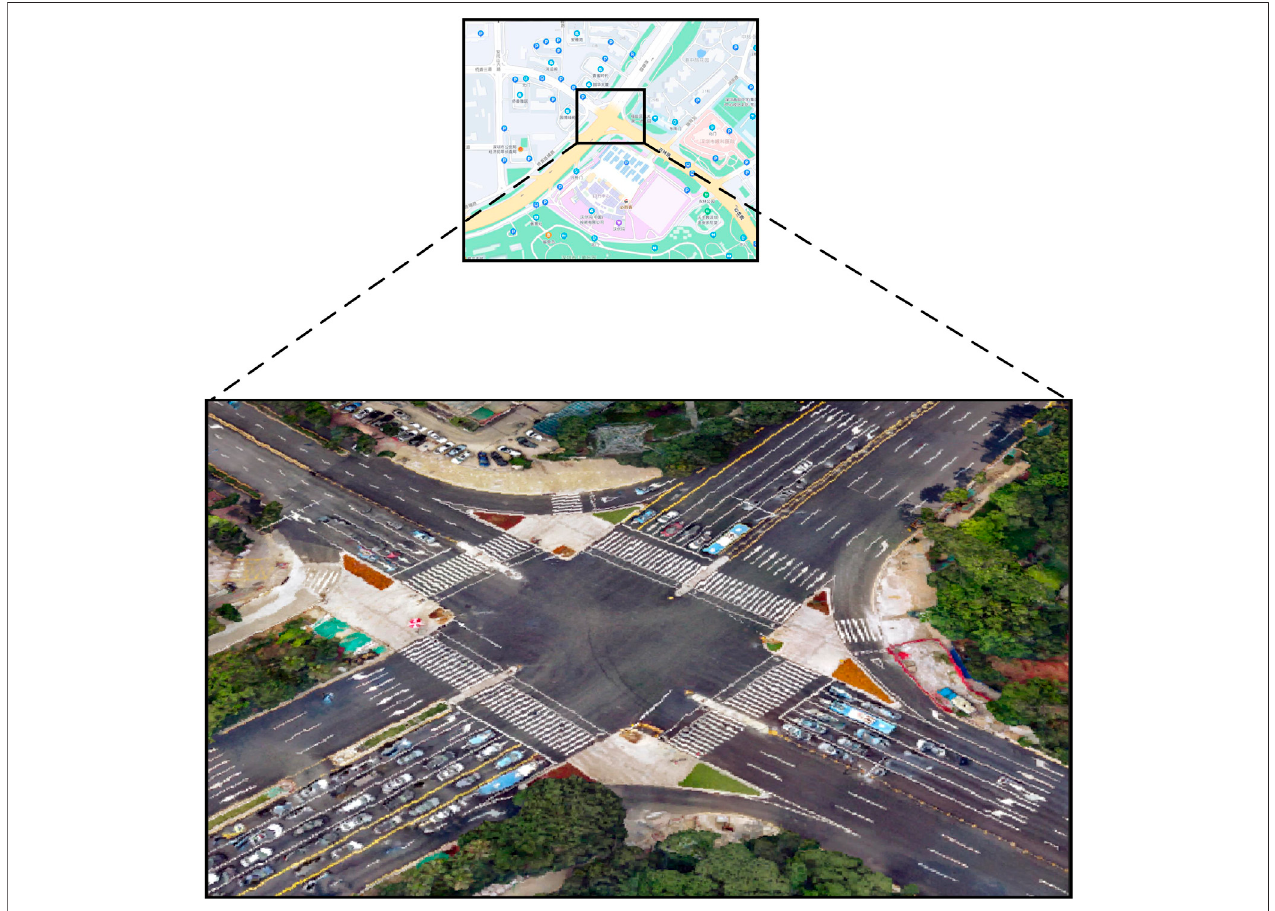
FIGURE 4 | Illustration of the study